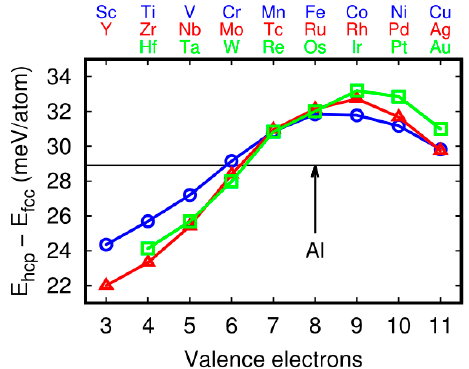
Figure 4. Stability of hexagonal-close packed hcp vs. face-centered cubic (fcc)aluminum—transition metals alloys. The supercell contained 47 Al atoms and one impurity atom. In the case of the fcc structure, the atoms were arranged as shown on Figure 1a. In the case of the hcp structure, a